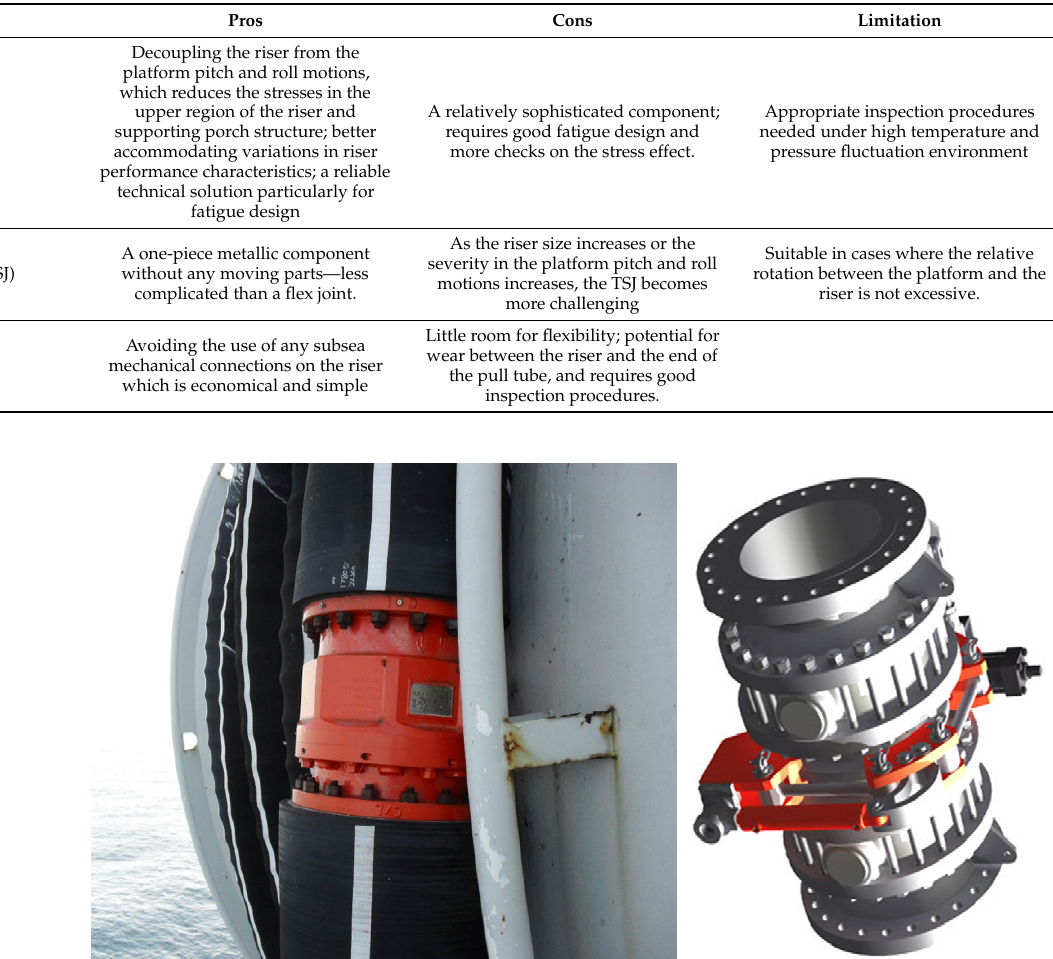
Table 6. Pros and Cons of various hang-off systems.